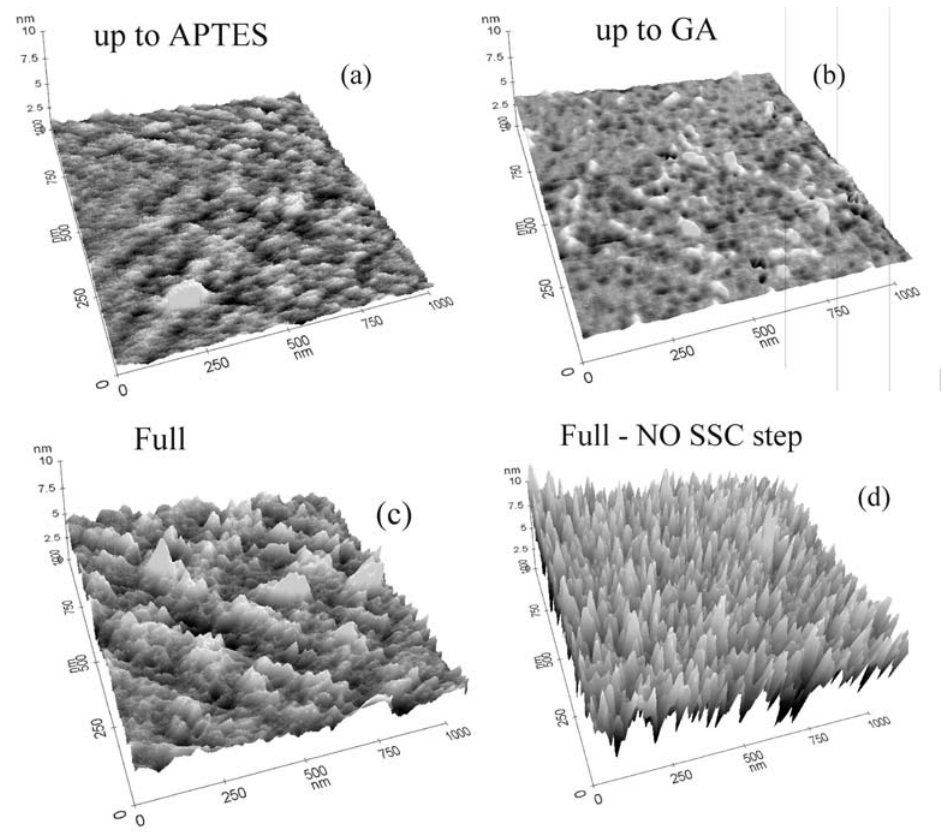
Figure 2. AFM images of: (a) up-to-APTES, (b) up-to-GA, (c) fully processed (with GOx), and (d) fully processed (with GOx) without the first step (NO SSC step). The vertical scale is 10 nm while the horizontal scales are both 1 μ m. Higher peaks appear lighter on a gray